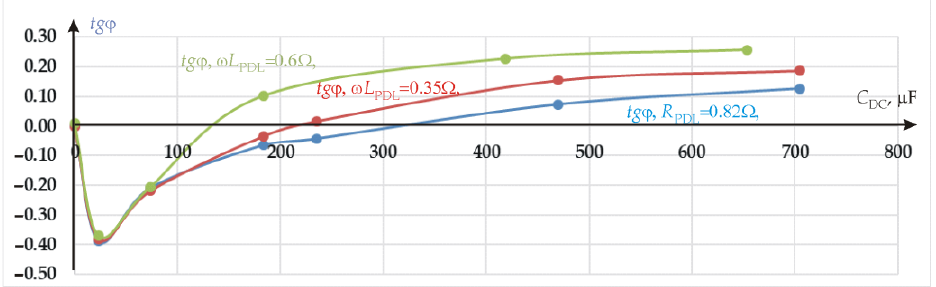
Figure 10. tg ϕ at the point of connection of the single-phase diode rectifier supply-side device to the PDL as a function of DC circuit capacity value in case of different PDL inductivity and